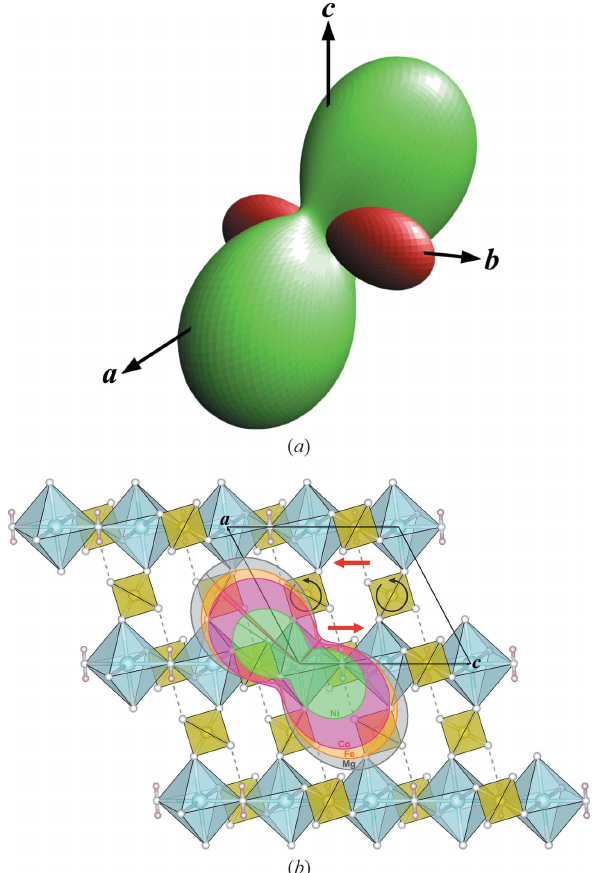
Figure 3 ( a ) Thermal expansion tensor in MgSO 4 (cid:2) H 2 O at 113 K ( T ref = 293 K), with green indicating positive values, red indicating negative values; ( b ) cross sections of the thermal expansion tensors of kieserite-type compounds M 2+ SO 4 (cid:2) H 2 O ( M 2+ = Mg, Fe, Co, Ni) at 113 K ( T ref = 293 K) in the ac plane, superimposed on a respective projection of the structure of kieserite at 113 K. For increasing temperature, black arrows show the sense of tetrahedral rotations around the twofold axis, red arrows indicate the resulting opposing translations of neighboring octahedral–tetrahedral chains within the ac plane (see text). The tensor surface and cross sections were prepared with the program WinTensor (Kaminski,